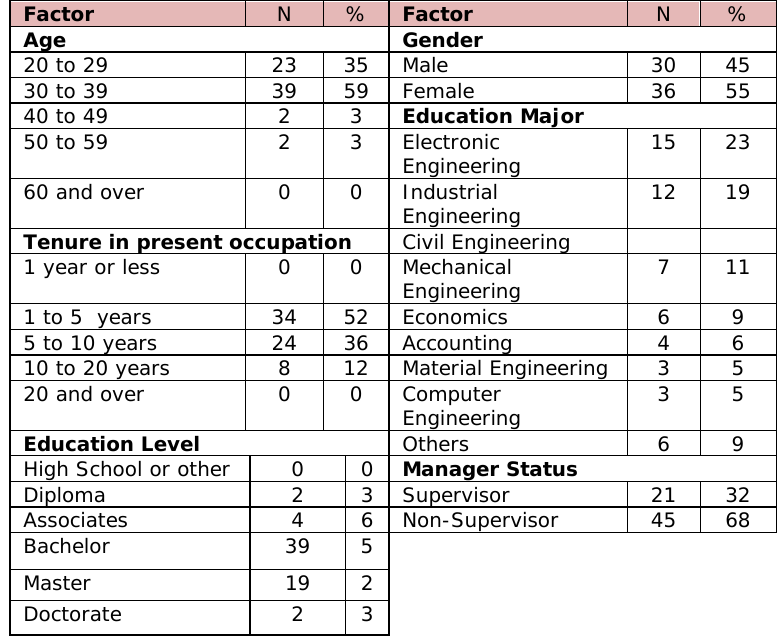
Table 2. "Sample demographic